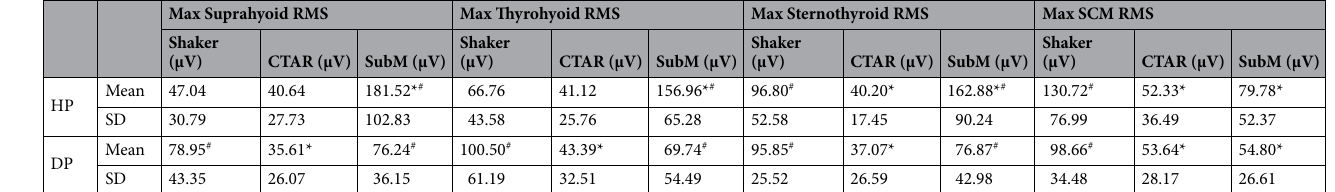
Table 2. The maximal RMS value of the suprahyoid, thyrohyoid, sternohyoid, and SCM muscles in healthy participants and patients with dysphagia. RMS; root mean square, SD; standard deviation, CTAR; chin tuck against resistance, SubM; submandibular push exercise, SCM; sternocleidomastoid, Max; maximum, HP; healthy participants, DP; dysphagic patients. versus Shaker; * p < 0.05, versus CTAR; # p <